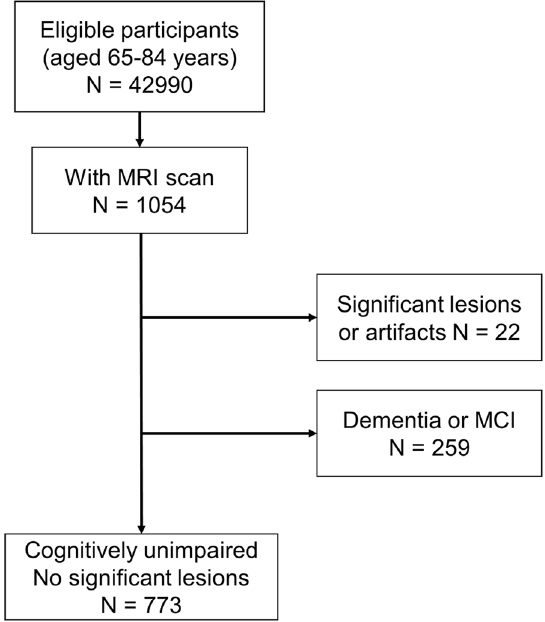
Fig. 1 The inclusion process of subjects. A fi nal total of 773 cognitively unimpaired elderly with no visible brain lesions were